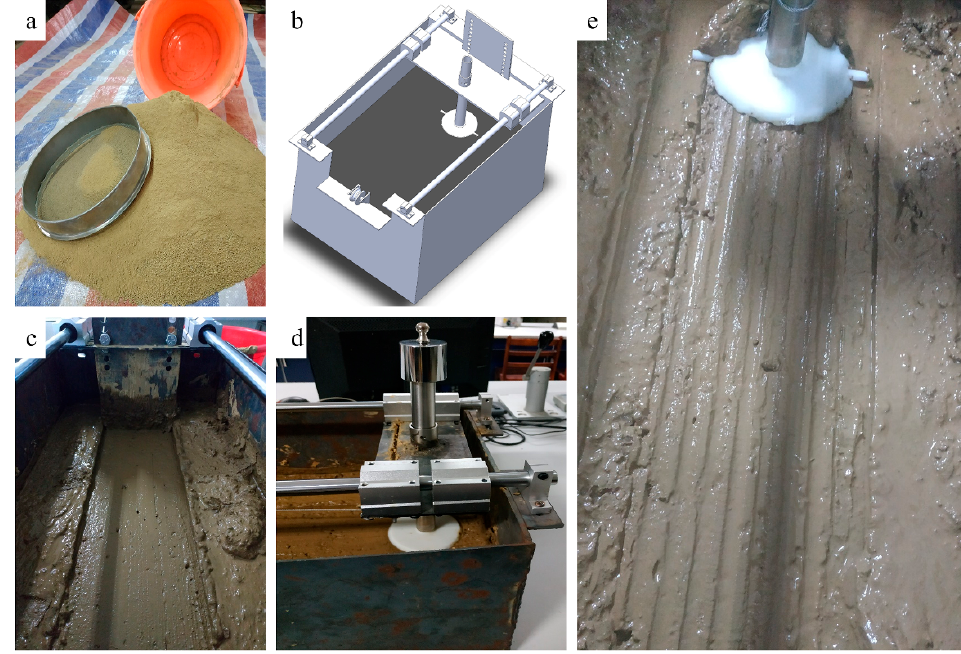
Figure 4. Experimental setup for the sliding resistance test: ( a ) the sieved soil; ( b ) creating an appro- priate soil bin to test sliding resistance; ( c ) flattening and smoothing of soil surfaces; ( d ) exposing the soil paste to constant normal stress of 1025 N·m − 2 for one minute; ( e ) pulling the test disc for 40 cm of soil bin length.